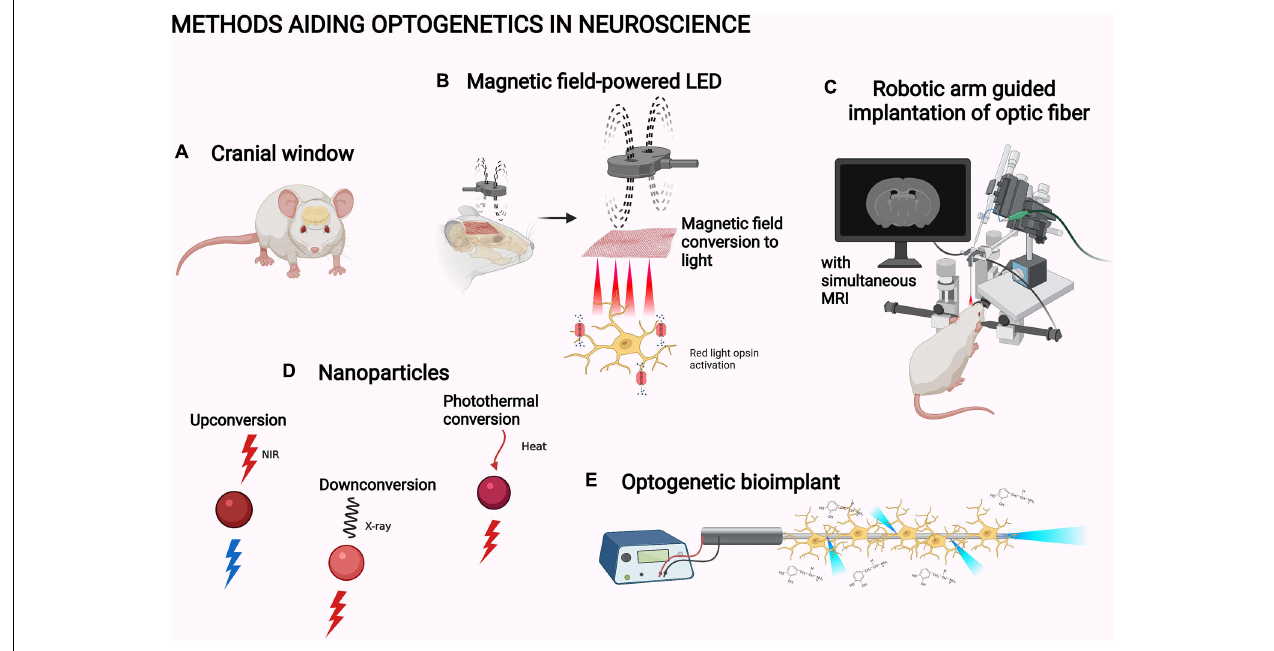
FIGURE 5 | Methods aiding optogenetics in neuroscience. (A) Cranial window (Cha et al., 2020). (B) Magnetic field-powered LED (Lee et al., 2020). (C) Robotic arm guided implantation with magnetic resonance imaging, MRI (Chen et al., 2019). (D) Upconversion nanoparticle, UPNC (Wang et al., 2019), X-ray downconverting nanoparticle (Chen et al., 2021), and photothermal-converting nanoparticle (Chen X. et al., 2020; Qiao et al., 2021). (E) Optogenetic bioimplant (Vasudevan et al., 2019). The objects are not to scale. The figure was created with